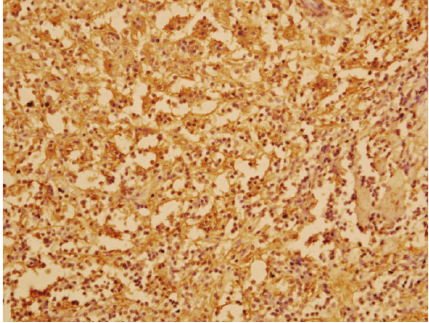
Figure 4: Photomicrograph of immunohistochemistry of the lesion showing positive reactivity of the histiocytes to S-100 protein (S-100, × 400).